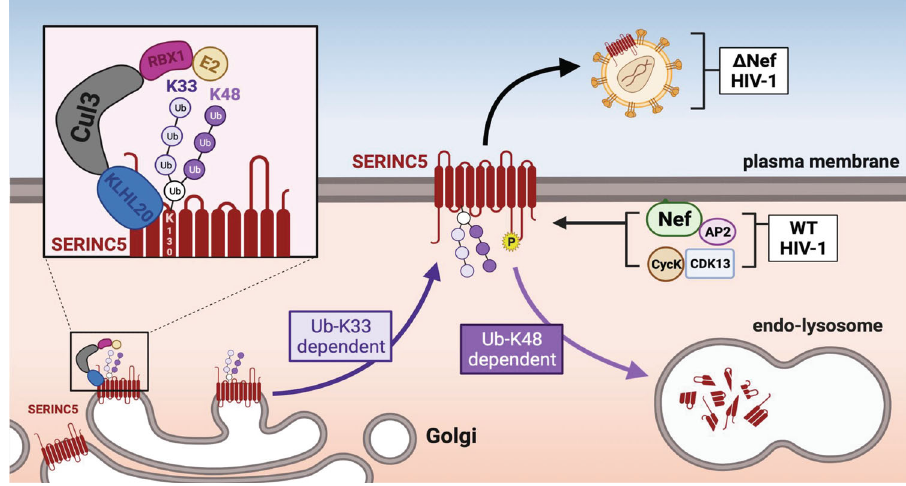
Fig. 7 A model of how CRL KLHL20 determines SERINC5 traf fi cking and expression. CRL KLHL20 catalyzes SERINC5 polyubiquitination at the TGN and produces K33/K48-brached chains at K130 of SERINC5. The K33-linked Ub chain (Ub-K33) potentiates SERINC5 traf fi cking to the plasma membrane, where it is packaged into HIV-1 virions to inhibit viral infection in the absence of Nef. However, when Nef is expressed, this viral accessory protein recruits CycK/CDK13 to phosphorylate the ICL4 of SERINC5. This phosphorylation triggers SERINC5 conformational change, resulting in recruitment of the AP2 complex to SERINC5 via Nef. SERINC5 is then targeted to the endocytic pathway and degraded in lysosomes via the K48-linked Ub chain (Ub-K48). BioRender was used for making the